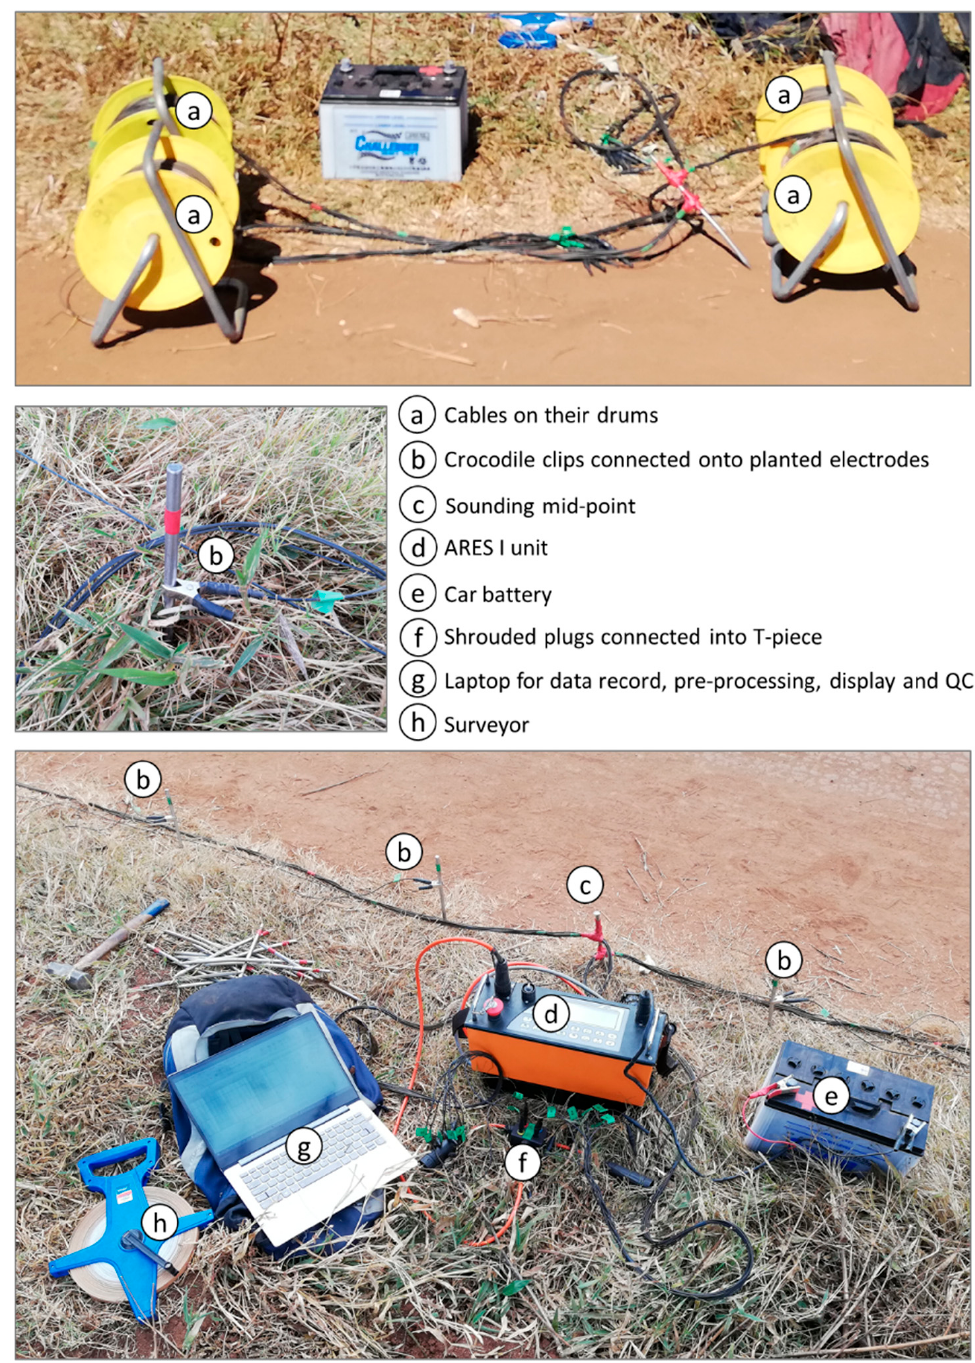
Figure 5. Photographs of the survey equipment .